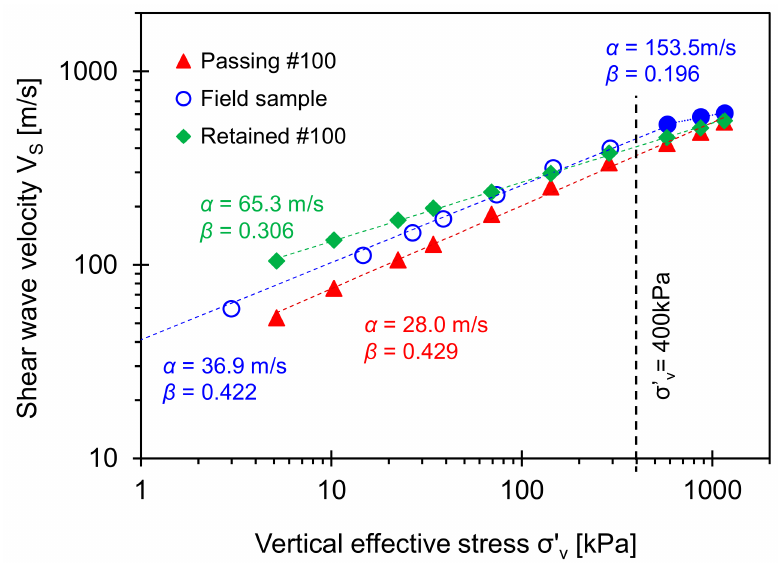
Figure 12. Shear wave velocity for Savannah River sands versus vertical effective stress (note: Sampling depth is 19.20 m–19.35 m).